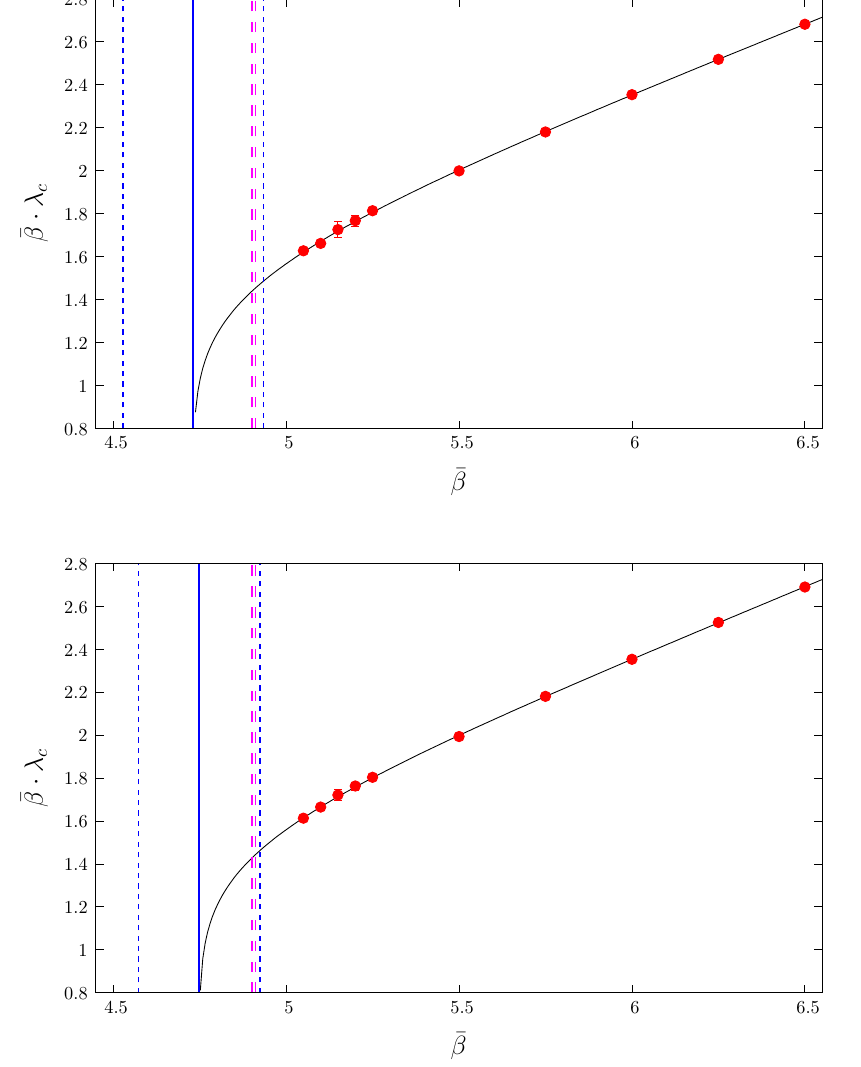
Figure 11 . Mobility edge λ c phys = ¯ β (bottom). The function ¯ βh (¯ β ) [see eq. (4.8)] obtained fitting λ c is also shown (solid line). The positions of ¯ β 0 and corresponding error band (blue line) and the error band of ¯ β c (magenta line) are also